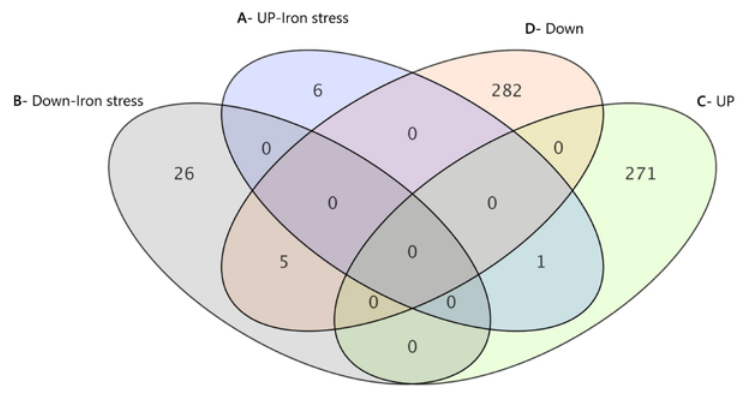
Figure 9. Venn diagrams of common and non-common gene lists; A = {UP-FC ([ M8FE ] vs. [ 905 ] under iron stress}, B = {DOWN-FC ([ M8FE ] vs. [ 905 ] under iron stress}, C = {UP-FC ([ M8FE ] vs. [ 905 ] under control cond.}, D = {DOWN-FC ([ M8FE ] vs. [ 905 ] under control cond.}. FC indicates fold